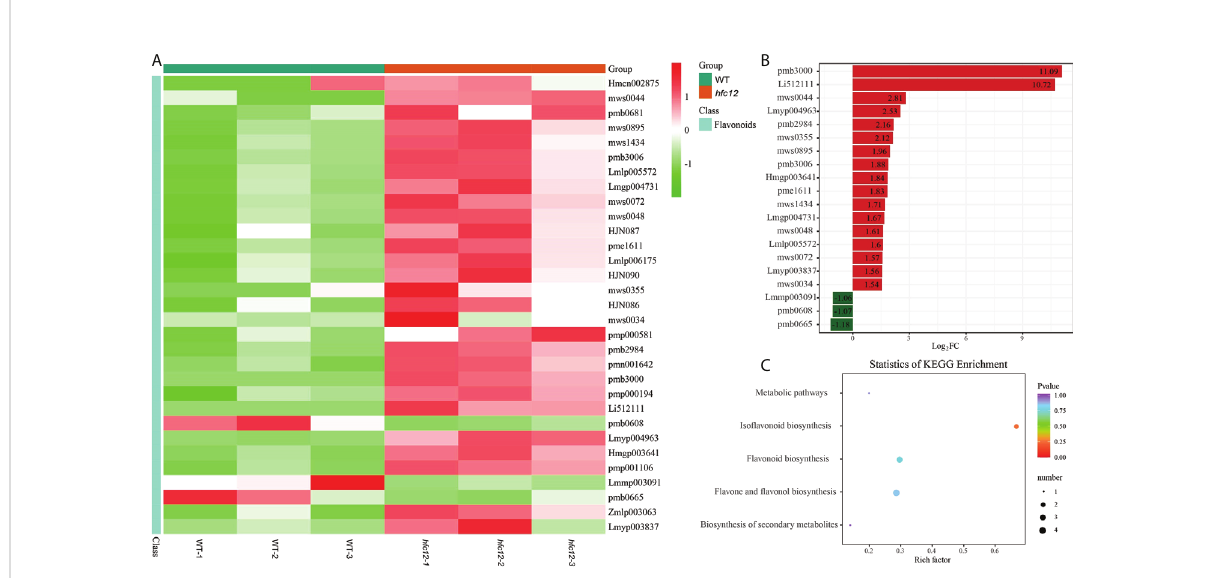
FIGURE 3 Metabonomic analysis of WT and hfc12 . (A) Heatmap of DAFs between WT and hfc12 . The columns represented samples, and the rows represented the differential metabolites. The differential metabolite cluster tree was shown on the left side of the plot. The different colors indicated the values obtained after standardization of the relative content (red represents high content, green represents low content). (B) Bar chart of DAFs. (C) KEGG enrichment scatter plot of